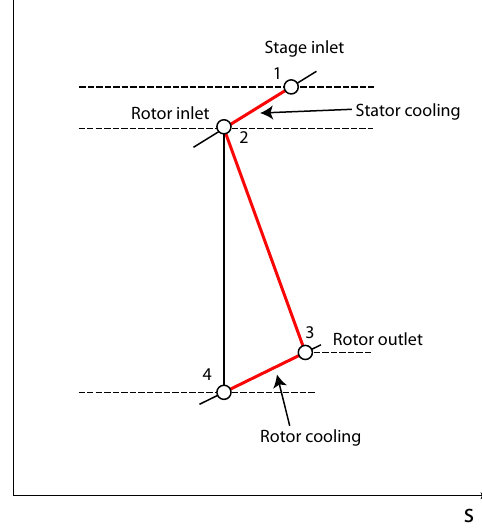
Figure 3. Expansion model in a cooled turbine stage after [16,17].